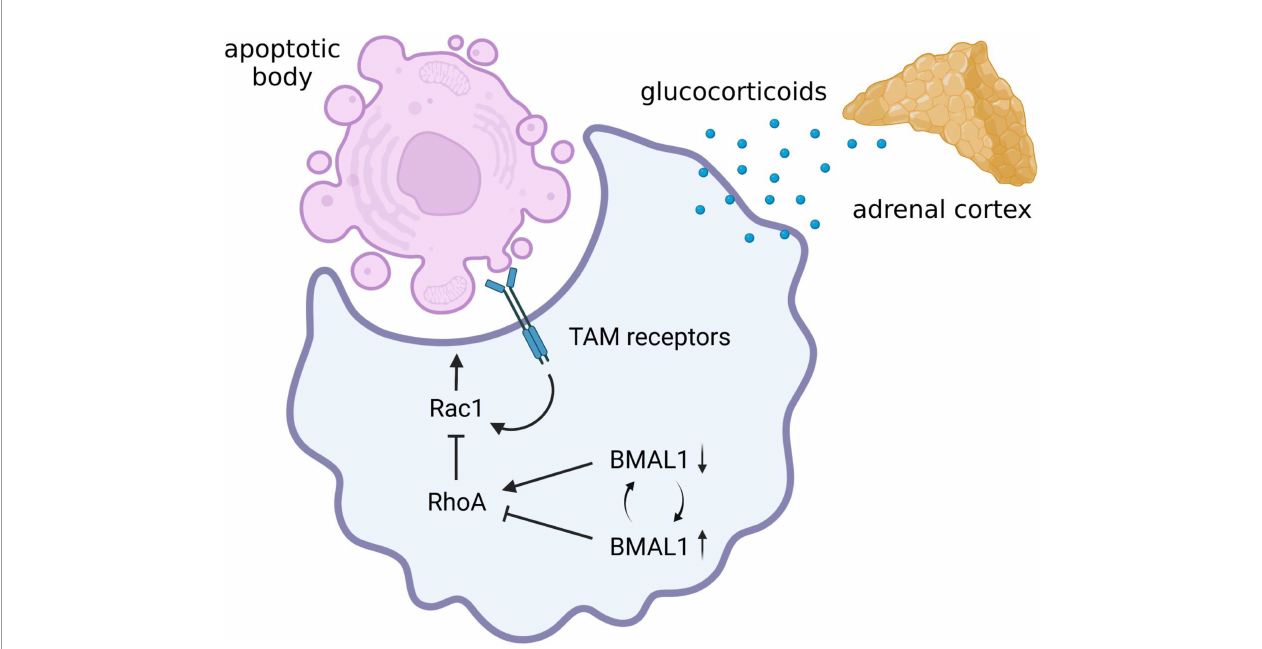
FIGURE 4 | Possible circadian regulation of efferocytosis by alveolar macrophage. Alveolar macrophages have remarkable efferocytosis activity mediated by the TAM receptors. There is still no evidence of whether the efferocytosis activity of alveolar macrophages is circadian regulated. However, augmented activation of RhoA due to BMAL1 deprivation can lead to a marked decrease in efferocytosis activity of alveolar macrophages by inhibiting Rac1 activity. In addition, since glucocorticoids augment efferocytosis, macrophage efferocytosis may also be in fl uenced by circadian rhythmicity of hypothalamic-pituitary-adrenal (HPA) axis activity. Therefore, there is a possibility that the immunomodulatory effects of intracellular clock genes and the diurnal oscillation of sympathetic-pituitary-adrenal axis activity determine the severity of pneumonia during virus infection by controlling the clearance of apoptotic bodies. BMAL1, brain and muscle ARNT-like 1; Rac1, Ras-related C3 botulinus toxin substrate 1; RhoA, Ras homolog family member A; TAM, Tyro 3, Axl, and proto-oncogene c-mer tyrosine